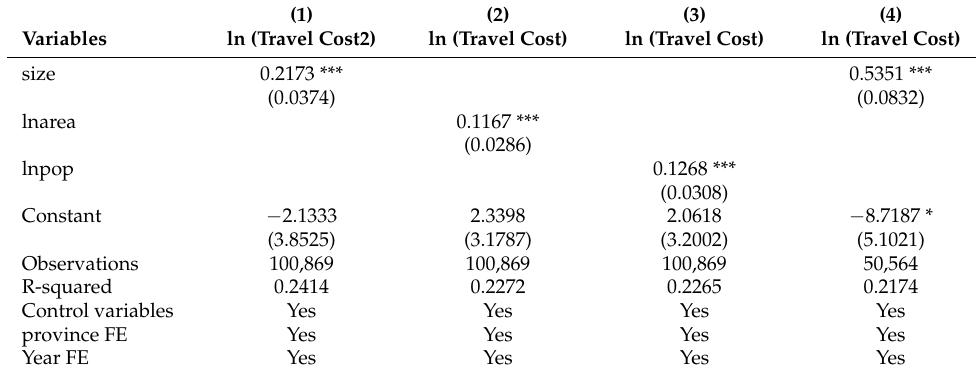
Table 3. The robustness test